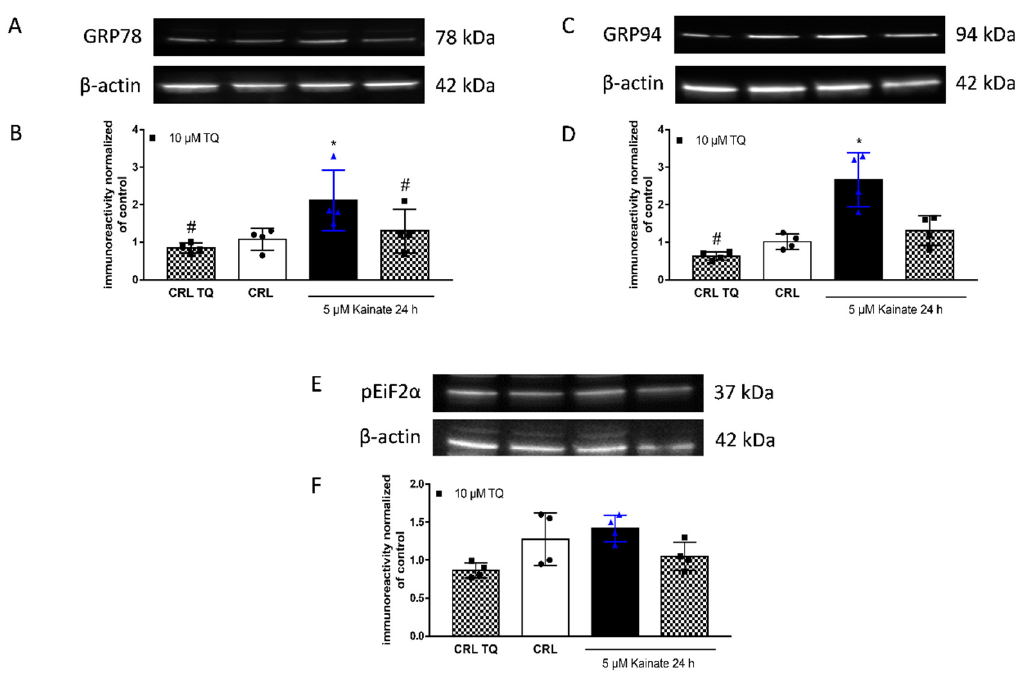
Figure 3. Effects of TQ on unfolded protein response (UPR)-related genes and phosphorylated eIF2 α in slices. Slices were exposed to 10 µ M of TQ in the absence or presence of KA (5 µ M for 24 h) and then processed for WB. ( A , C , E ): Representative blots for GRP78 or GRP94 or pEiF2 α or β -actin. ( B , D , F ): Quantitative analysis of immunoreactive bands shows that TQ treatment in basal conditions does not change the total proteins levels but is able to reduce KA-induced enhancement of GRP78 and GRP94 levels, without changing the phosphorylation state of eIF2 α . Dot blots show the results of four experiments from independent slice preparations and each dot is the pool of four slices. * p < 0.05 vs. CRL and # p < 0.05 vs. kainate. (ANOVA + Tukey’s w -Test).